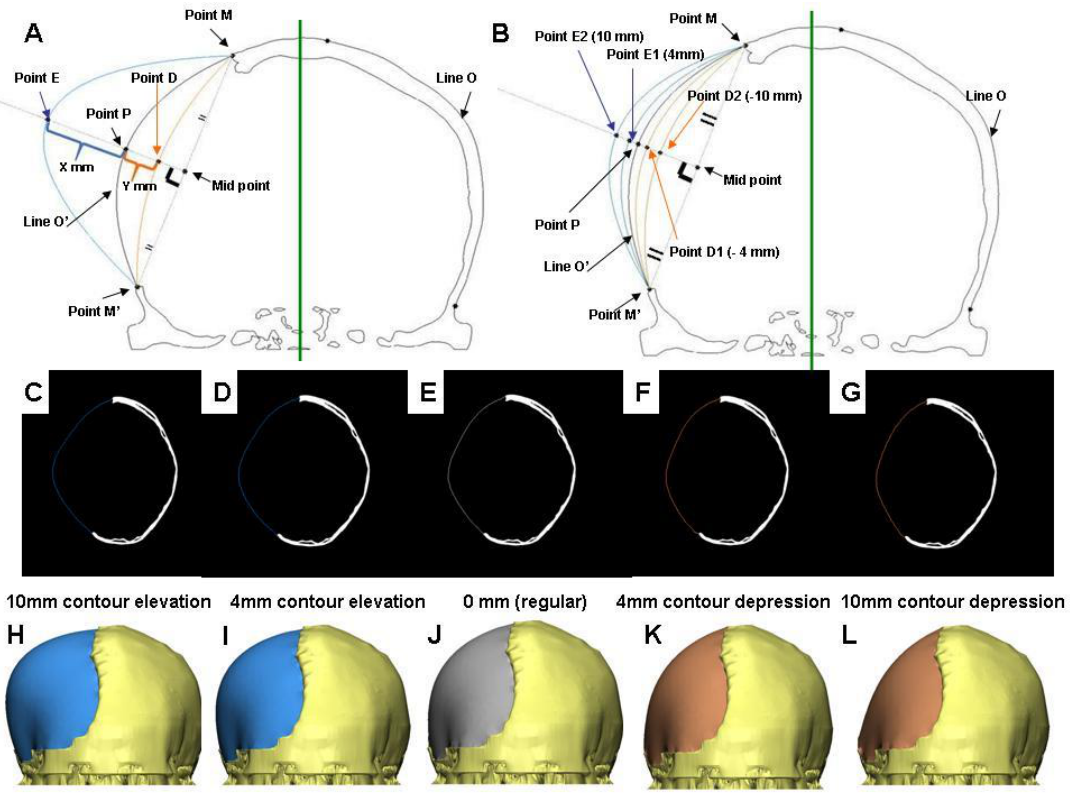
Figure 4. CAD modeling with the contour adjustment of case 3. ( A ) Schematic illustration of the definition for contour elevation (Point M-E-M’-connected arc), and depression (Point M-D-M’-connected arc). ( B ) Schematic illustration of the elevated and depressed contour of the skull defect. Points E1, E2, D1, D2 represent intersection points where contours are 4 and 10 mm outwardly elevated, and inwardly depressed respectively. The reconstructed contour from the skull defect on the CT images: symmetrically filled ( E ), contour elevation of 4 ( D ), and 10 mm ( C ), contour depression 4 ( F ), and 10 mm ( G ). ( H – L ) represented the respective 3-D CAD models.